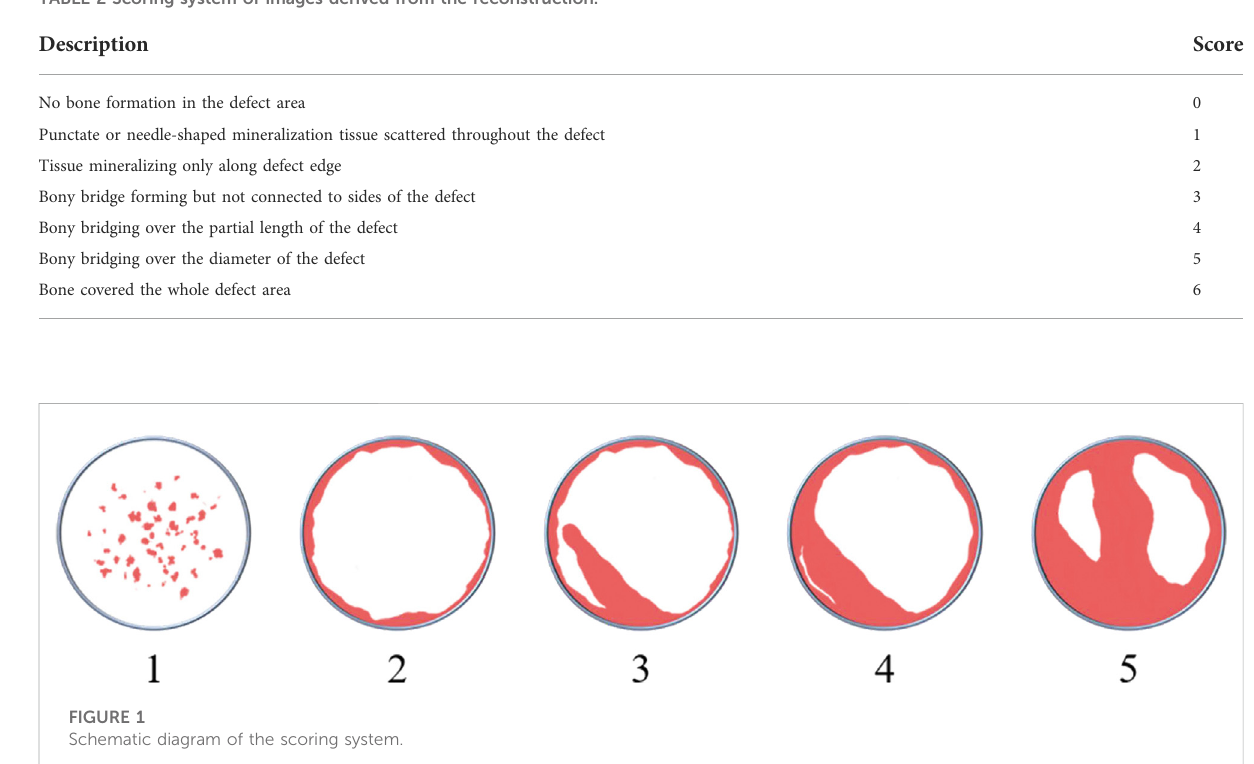
TABLE 2 Scoring system of images derived from the reconstruction.